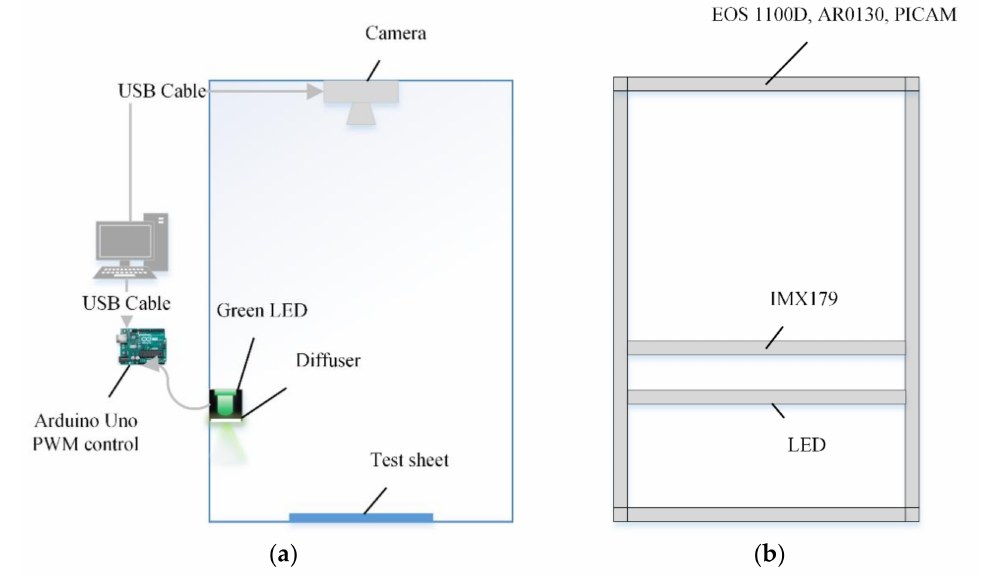
Figure 1. Gel-document emulation system: ( a ) configuration; ( b ) fixed